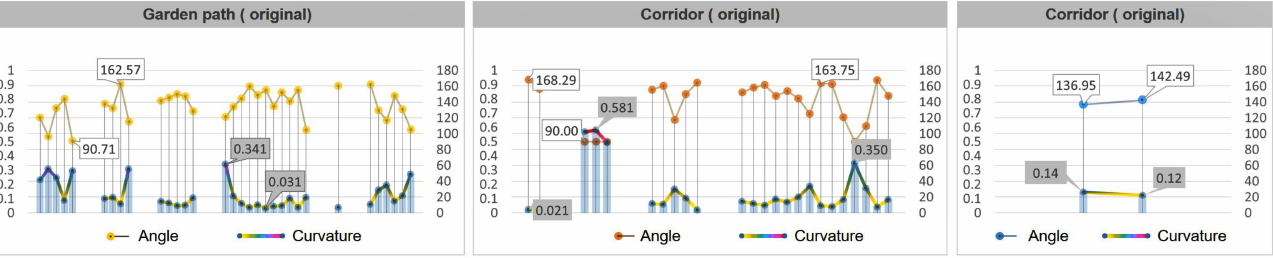
Figure 15. The original path and its angle and curvature.